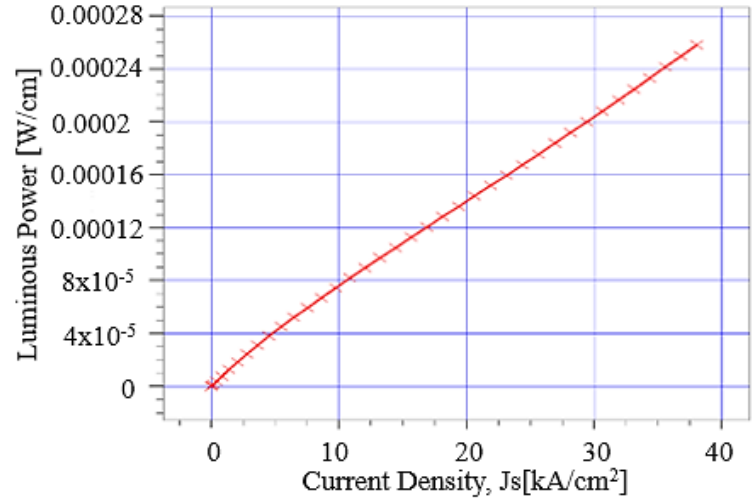
Figure 7. Anode current density vs. luminous power of simulated SiC LED.